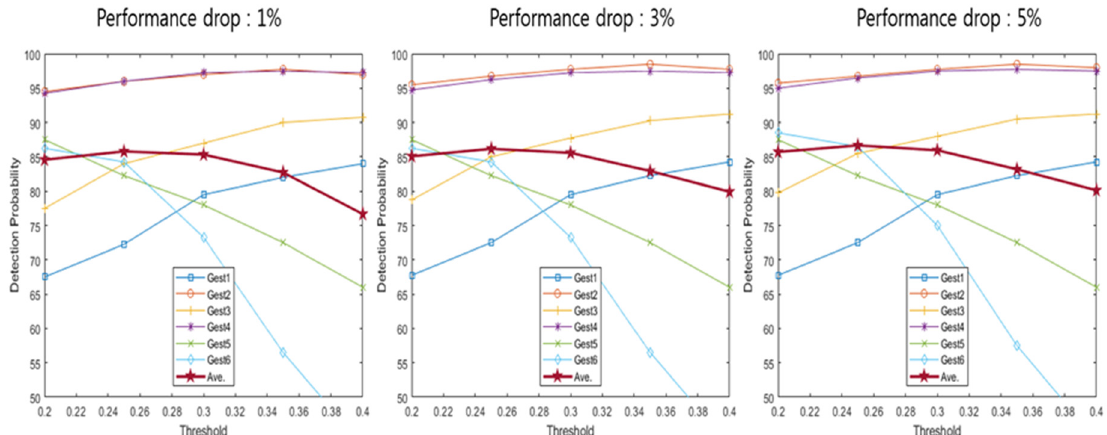
Figure 10. Detection probability of proposed method 1 (window 1).